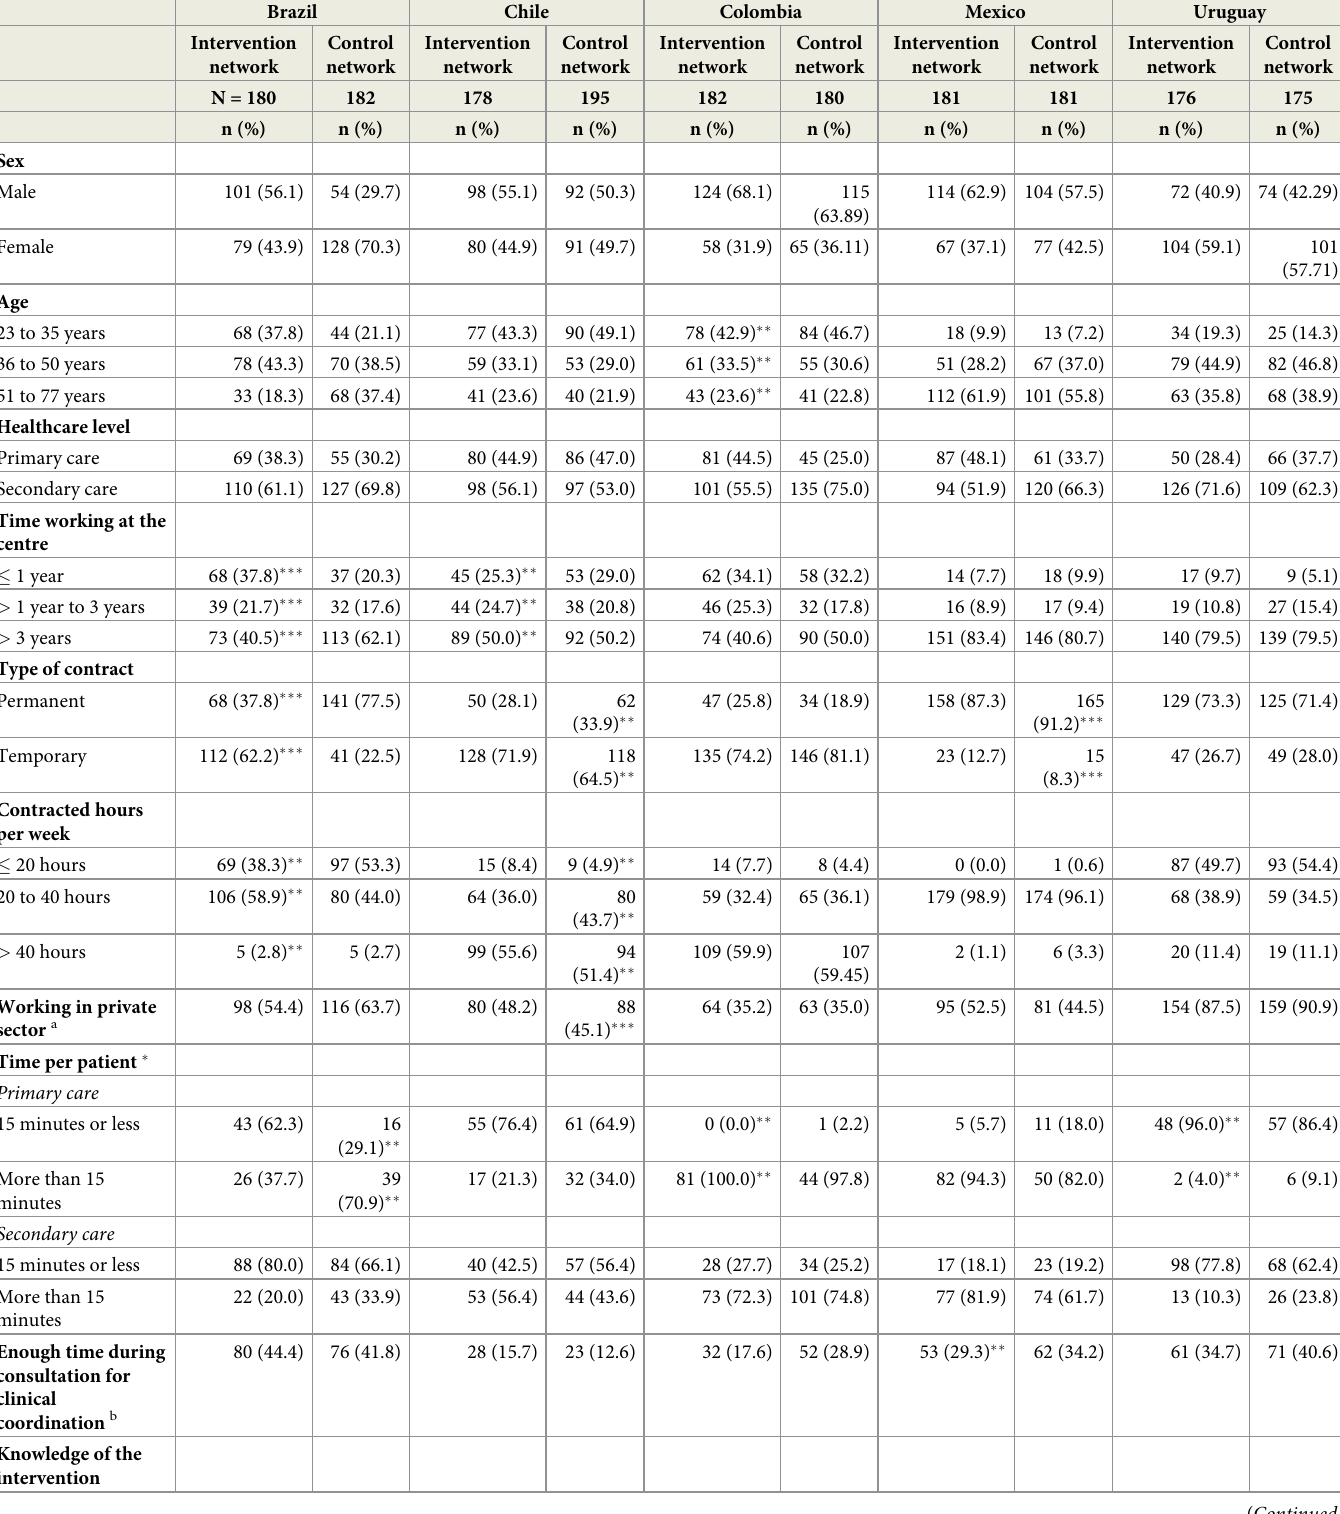
Table 2. Demographic, employment and organizational characteristics of the sample of the evaluation survey (2017), by country and network. Brazil Chile Colombia Mexico